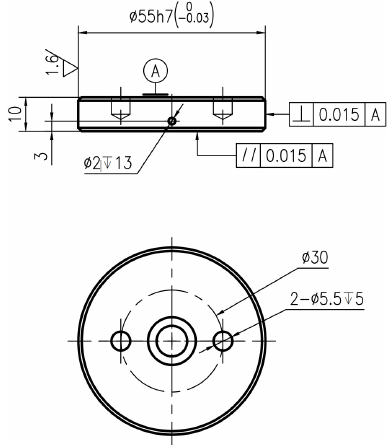
Figure 4. Structure diagram of disc sample (unit: mm).